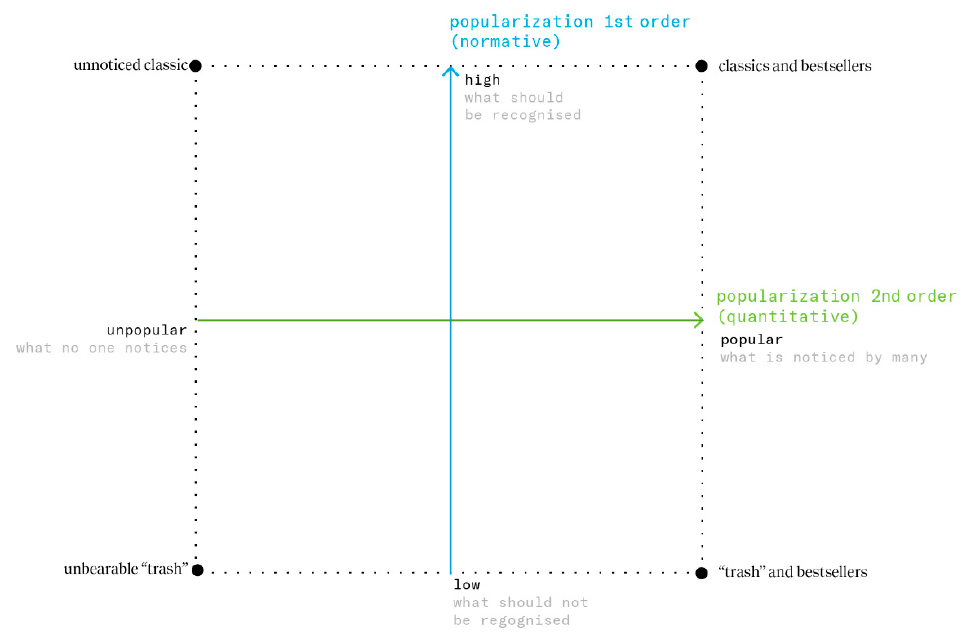
Figure 4. Matrix first- and second-order popularization.